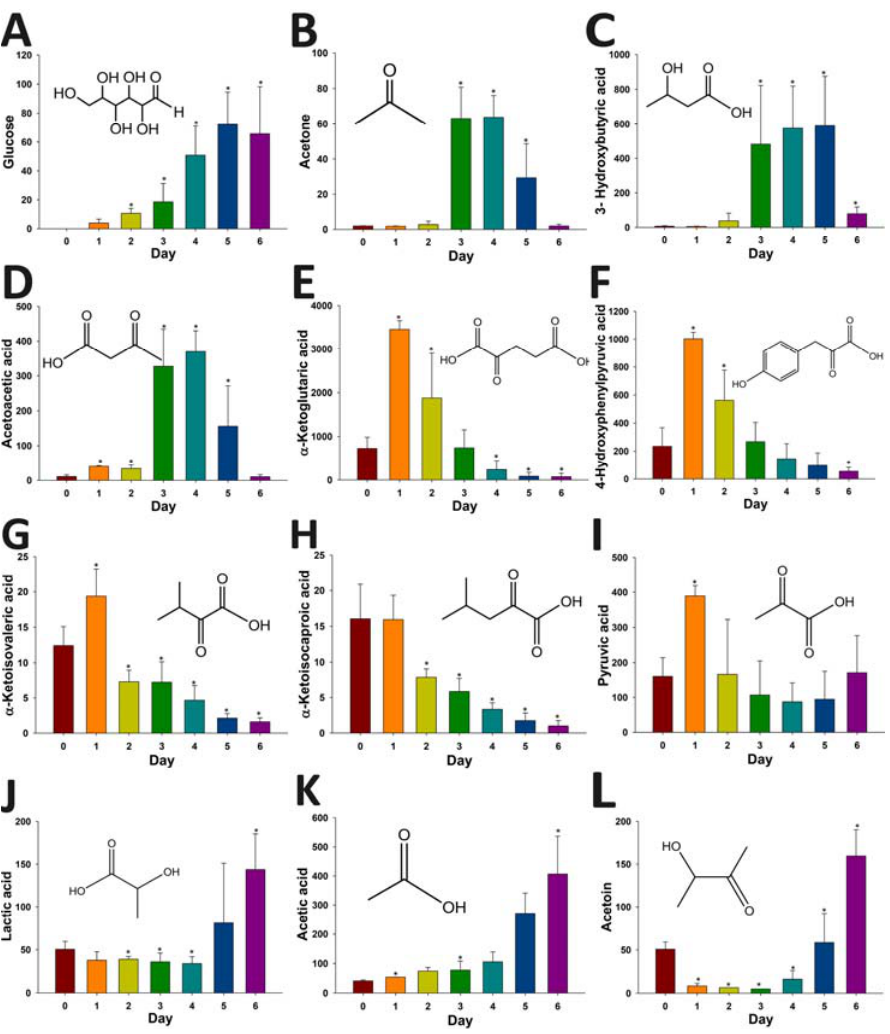
Figure 7. Influences of STZ treatment on carboxylic acid, aldehyde and ketone metabolites in mouse urine. The relative abundances of urinary metabolites identified in Figure 6B were determined by calculating the ratio between the signal ion counts (SIC) of the metabolite of interest and the total ion counts (TIC) of a sample. * indicates p < 0.05. ( A ) glucose; ( B ) acetone; ( C ) HBA; ( D ) acetoacetic acid; ( E ) α -ketoglutaric acid; ( F ) 4-hydroxyphenylpyruvic acid; ( G ) α -ketoisovaleric acid; ( H ) α -ketoisocaproic acid; ( I ) pyruvic acid; ( J ) lactic acid; ( K ) acetic acid; ( L )